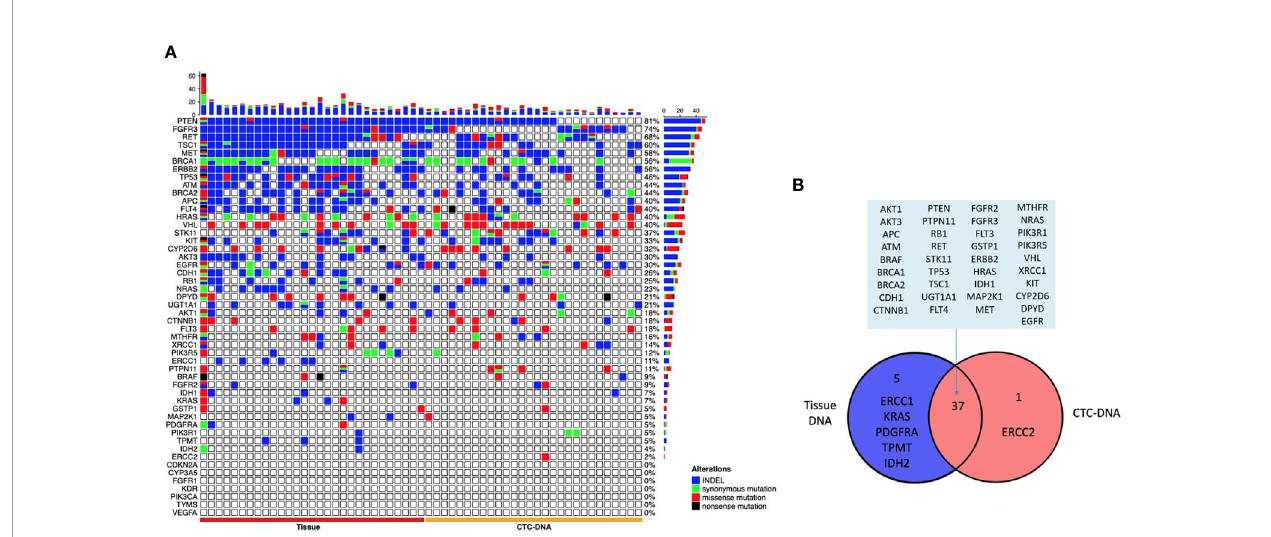
FIGURE 2 | The landscape of genome alteration using tissue and circulating tumor cells (CTCs) for targeted next-generation sequencing. (A) The heat map on the left shows the genomic change landscape of the tissue sample, and the right is the genomic change landscape of the CTC sample. The four colors indicate different mutation types, indels (blue), missense mutations (red), synonymous mutations (green), and meaningless mutations (black). (B) Venn diagram of genomic alterations using tissue and CTCs for targeted next-generation